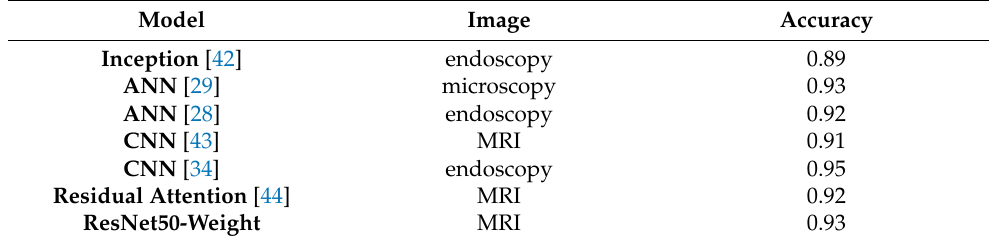
Table 3. Accuracy of recently reported